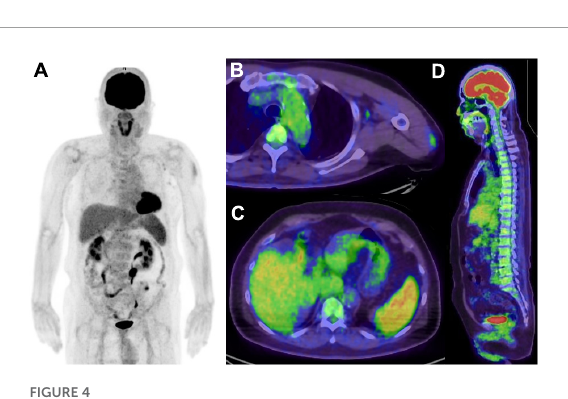
FIGURE4 Five days after COVID-19 vaccination in patient suspected recurrence of lung cancer. (A) MIP image of FDG PET, (B,C) axial image of PET/CT, (D) sagittal image of PET/CT. Increased FDG uptake were seen in left deltoid muscle, left axial lymph node, spleen and bone marrow, and all of them related to the